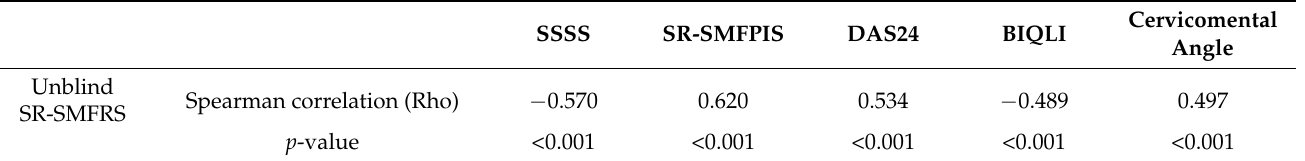
Table 6. Correlation of unblind SR-SMFRS with SSSS, SR-SMFPIS, DAS24, BIQLI, and cervicomental angle.